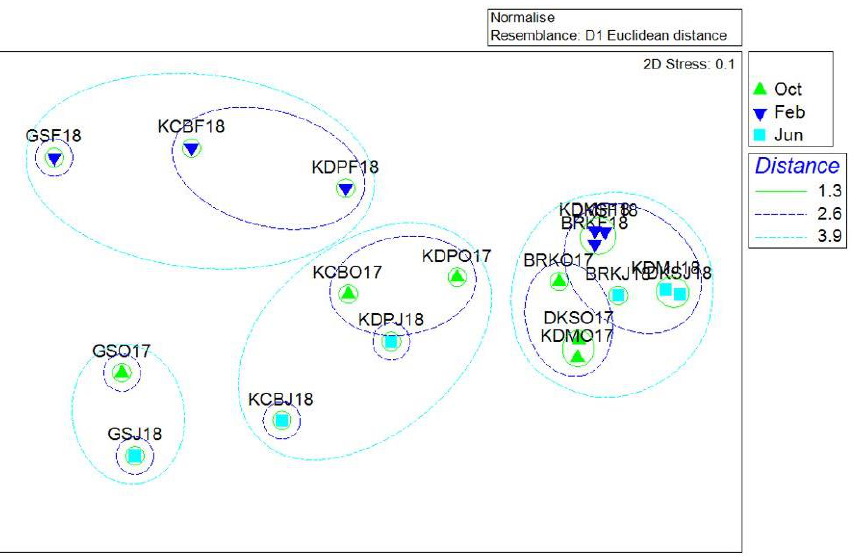
Figure 4. Non-metric multidimensional scaling (NMDS) of all the 18 samples collected from HRE, measured by the Euclidean distance. measured by the Euclidean